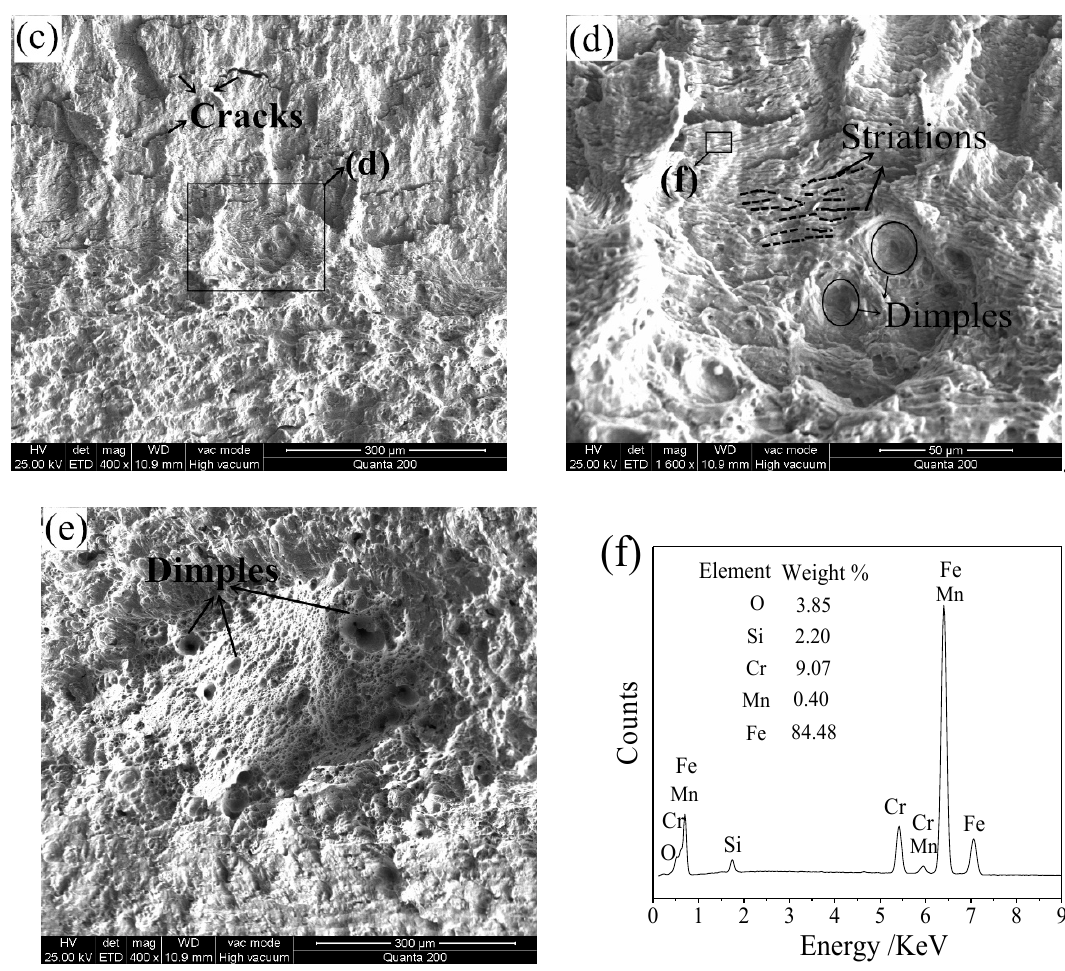
Figure 12. ( a ) Typical fracture surfaces of the specimen ( S max = 320 MPa, N = 1,034,413 cycles) with three regions tested at 650 °C; ( b ) crack initiation region and crack propagation region; ( c ) and ( d ) near rupture region; ( e ) final rupture region;( f ) EDS results of corresponding area on fracture surface.